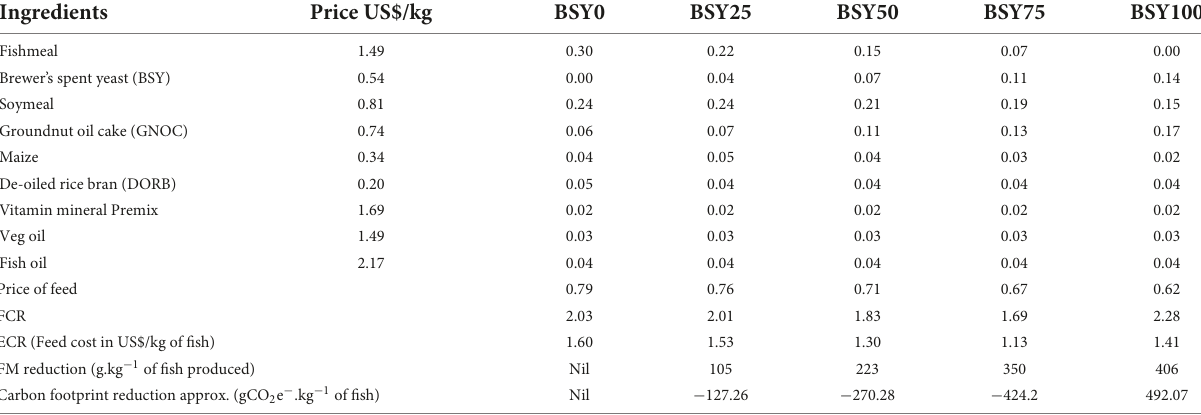
TABLE 4 Feed formulation cost, Economic conversion ratio and carbon footprint reduction value of different experimental diets.